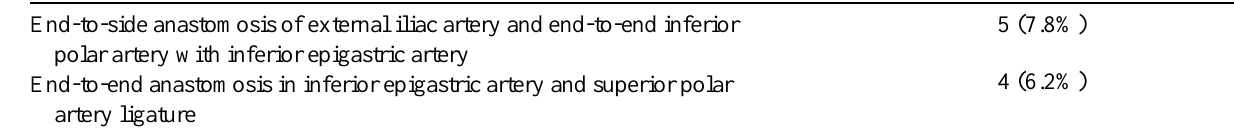
Table 3 – Vascular technique in situ in grafts with multiple arteries.